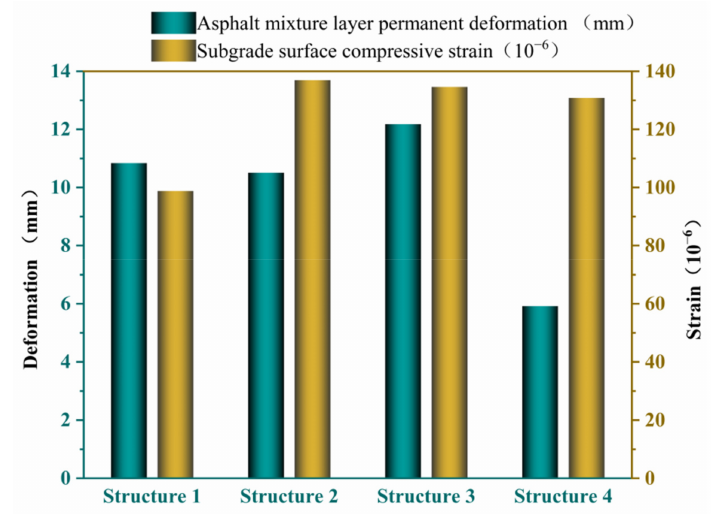
Figure 6. Antirutting performance parameters for pavement structure.